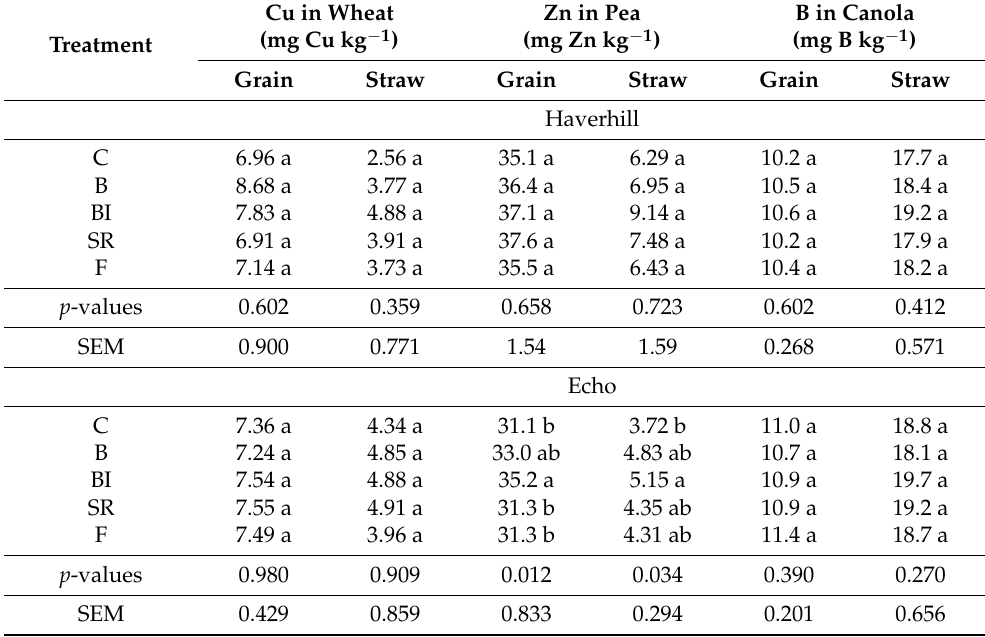
Table 3. The concentration of Cu, Zn, and B in grain and straw of wheat, pea, and canola, respectively, as affected by different fertilizer application strategies. Cu in Wheat Treatment Grain Straw Grain Straw Grain Straw